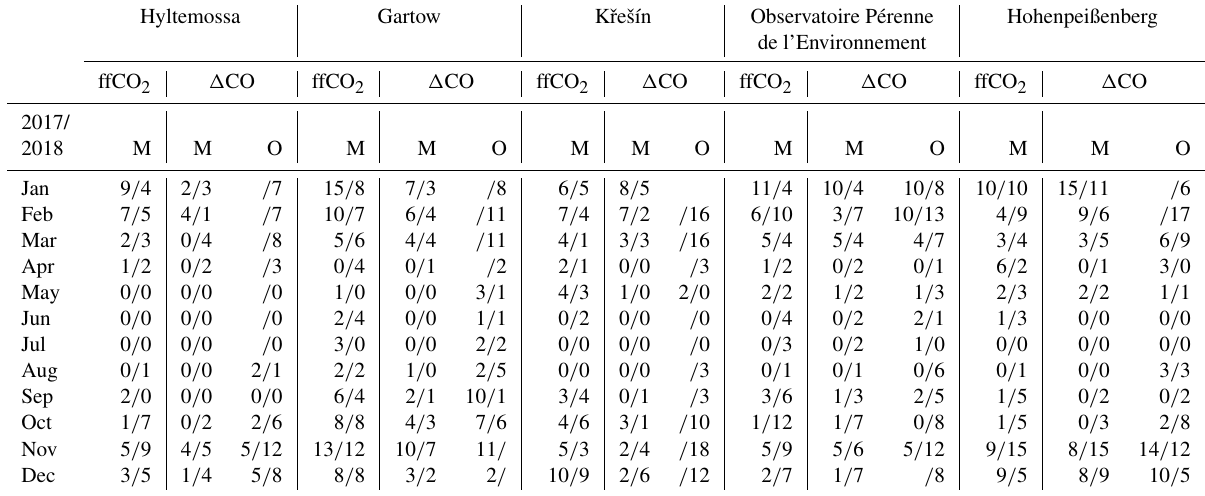
Table 1. Number of midday (13:00LT) ffCO 2 events > 4ppm estimated by the Stochastic Time-Inverted Lagrangian Transport (STILT) model for 2017 and 2018 and potential fossil fuel CO 2 events in both years, based on modelled (M) and observed (O) (cid:49) CO elevations of more than 0.04ppm compared to background (entries are empty if fewer than 20 afternoon CO observations are available in the respective